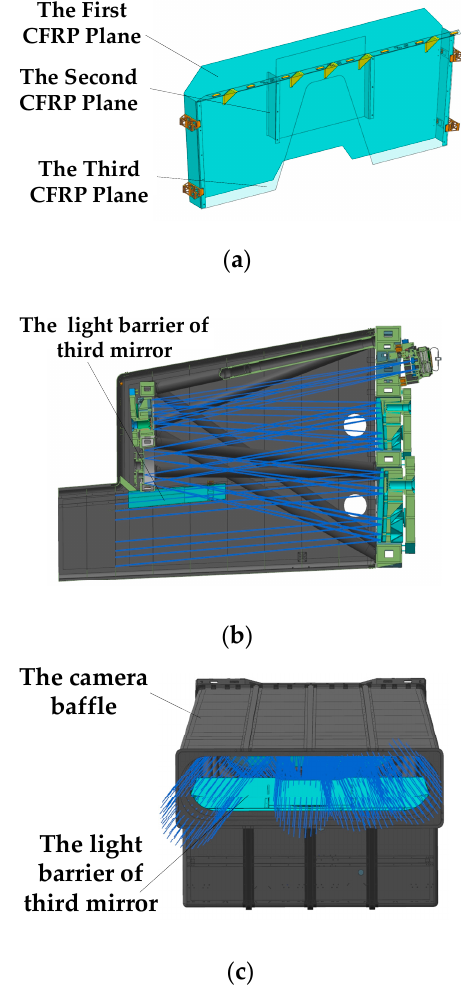
Figure 10. Schematic diagrams of the structure and installation position of the light barrier of the third mirror. ( a ) Structure diagram of the light barrier of the third mirror; ( b ) sectional view of the installation position of the light barrier in the camera; ( c ) schematic of light outside the field of view blocked by the light barrier.